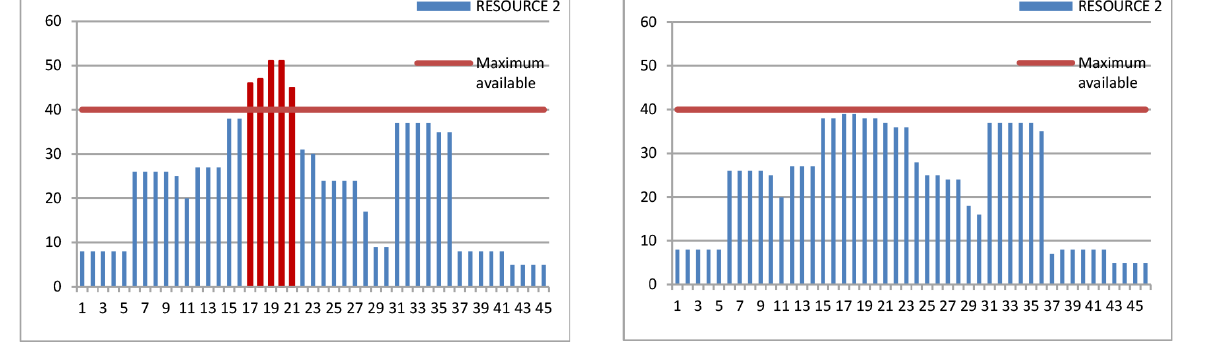
Figure 32. Daily usage of resource 2 throughout the calendar of the project (before using the method)-Experiment 2